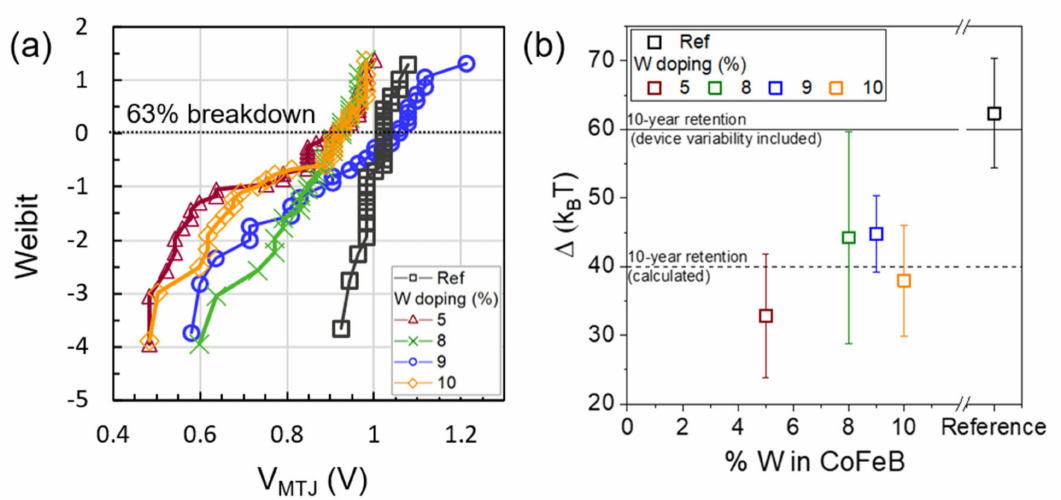
Figure 5. ( a ) Weibull distributions of DC breakdown performance for the different FL stack options. The dotted line indicates the point where 63% of the tested devices will fail. ( b ) Thermal stability (in k B T) estimated from fits of room temperature (RT) switching field distributions for the different FL stack